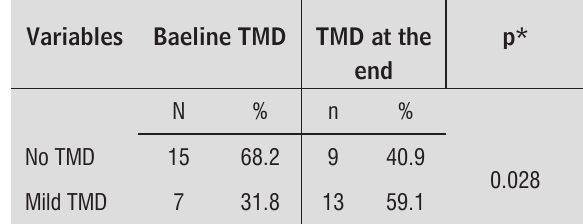
Table 3 - Analysis of the degree and frequency of base- line TMD and TMD at the end of the